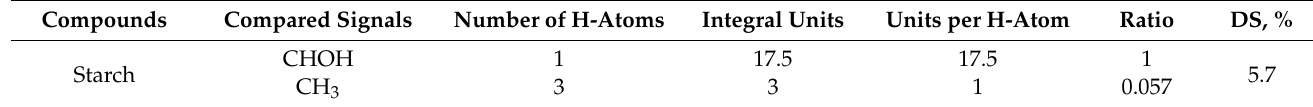
Table 3. DS evaluation from 1 H-NMR spectra signals (the Kuznechanka variety is given as an example). Compounds Compared